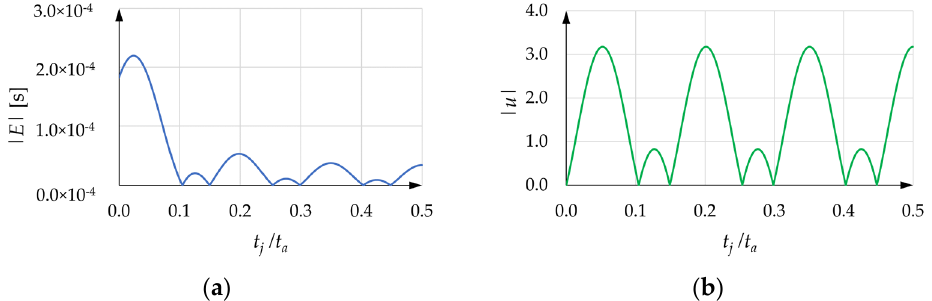
 (cid:95) t ( r equal to 6.7, t j ( r n , a equal to 6.7, t a equal to 0.2 s); ( b ) corresponding j n,a  (cid:95) t . t j j